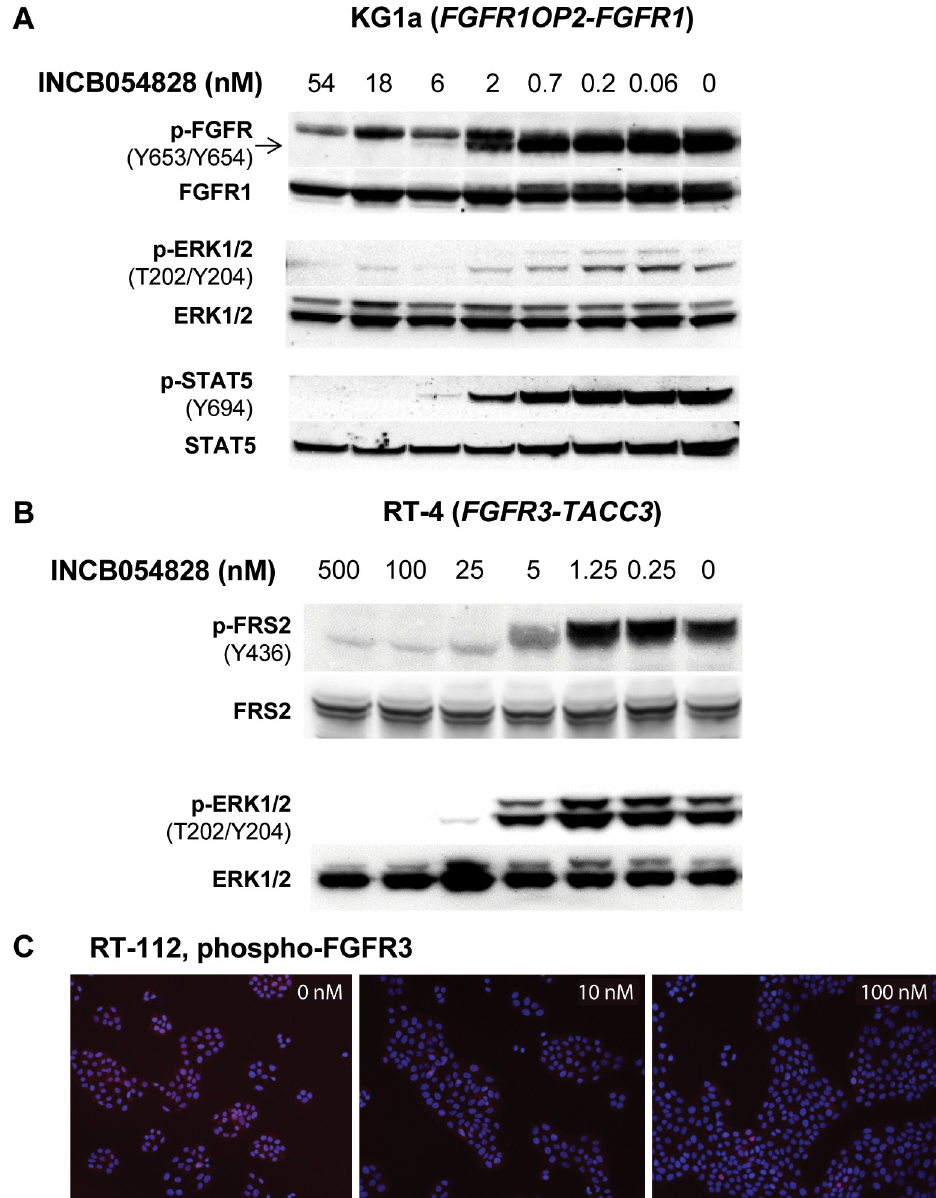
Fig 2. INCB054828 inhibits FGFR-dependent signaling pathways. (A) KG1a or (B) RT-4 cells were treated with INCB054828 for 2 hours, lysed and subjected to immunoblotting for phospho- and total proteins in the FGFR signal transduction pathway including FGFR, ERK, FRS2, and STAT5. (C) Concentration-dependent inhibition of phospho- FGFR3 by INCB054828 in RT-112 cells was determined using a proximity ligation assay with a mouse monoclonal anti-phospho-FGFR (Y653/Y654) and rabbit anti-FGFR. Original Western blot images are shown in S1 File (S1 Raw images). FRS2, a scaffolding protein that is a substrate of FGFR, and phospho-ERK (Fig 2B). FGFR3 phosphorylation was not detectable by Western blotting; however, a decrease was detected by proximity ligation assay that uses polymerase chain reaction to amplify the signal from the bound antibodies to phospho- and total FGFR3 (S4 Fig). Using this method, potent inhibition